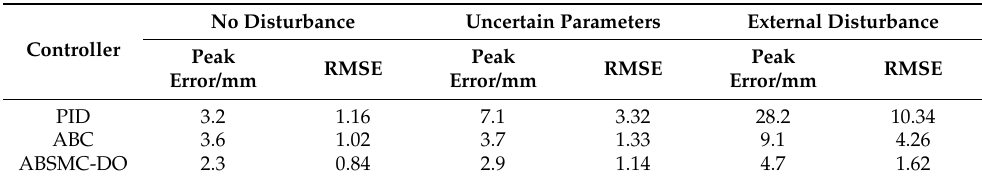
Table 2. Position tracking performance index under different controllers. RMSE, root mean square error; PID, proportion integral derivative; ABC, adaptive backstepping controller; ABSMC-DO, adaptive backstepping control based on the disturbance observer.